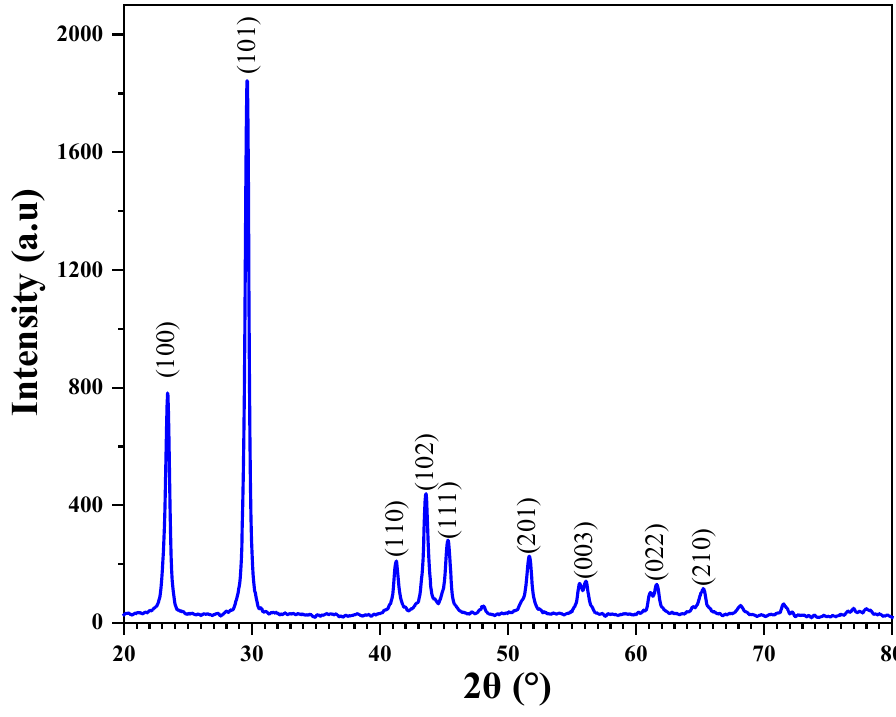
Figure 2. XRD pattern of synthesized Se NPs. Table 2. The crystallite size of Se NPs.